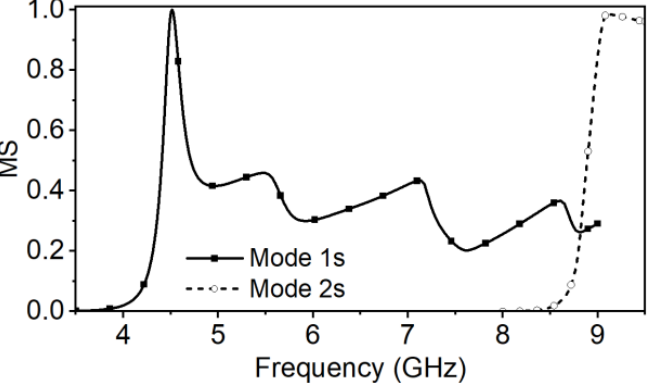
Figure 9. The MSs of the half-wavelength mode (Mode 1s) and the full-wavelength mode (Mode 2s) of the single slot.